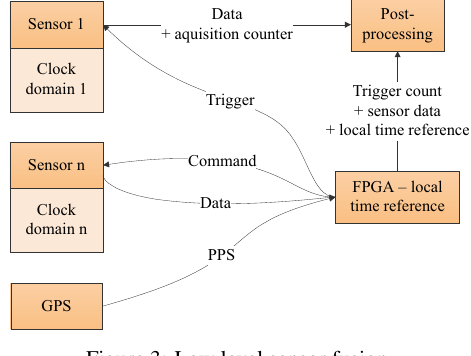
Figure 3: Low level sensor